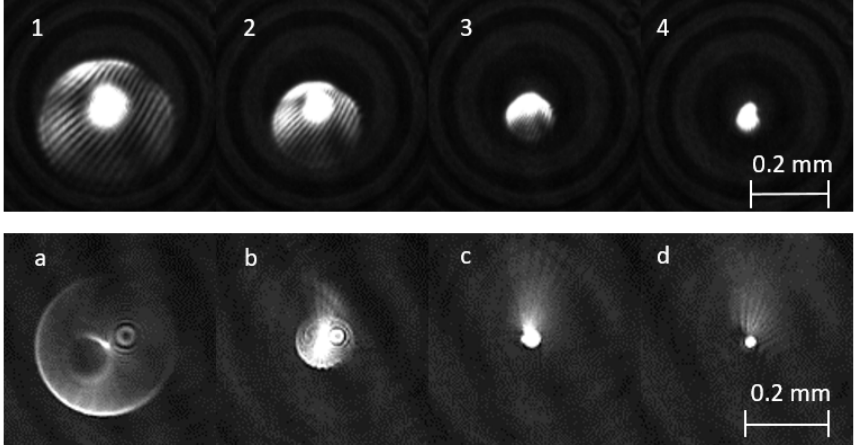
Figure 9 . Images of the approaching steps to the focus point of a Fresnel lens written onto the photochromic film ( T-Ph ). The sequence from ( 1 ) to ( 4 ) refers to a laser in the visible region ( λ = 650